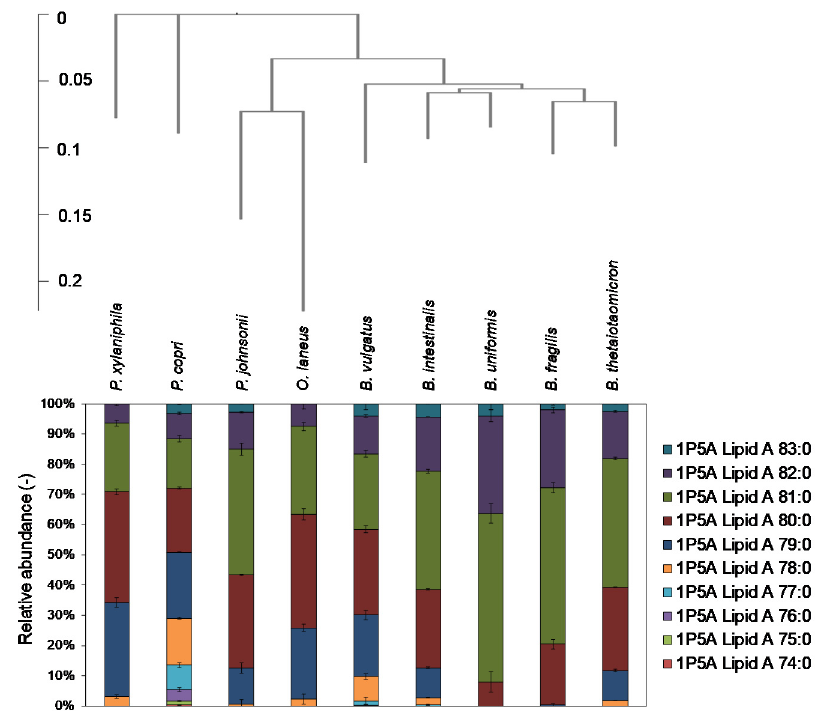
Figure 7. Relative peak areas of 1P5A lipid A molecular species in Bacteroidetes strains. The phylogenic tree was created based on the 16S ribosomal RNA sequences.